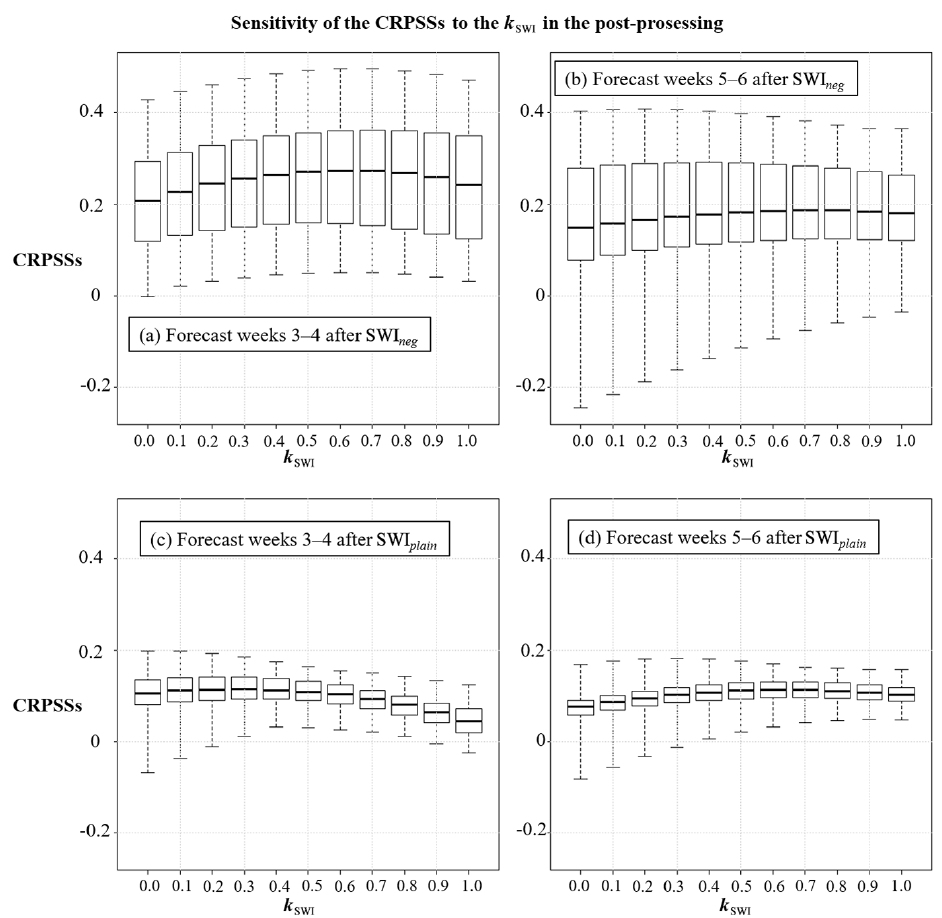
Figure 4. Sensitivity of the expected CRPSSs of the post-processed ECMWF surface temperature reforecasts to the k SWI ranging from 0.0 to 1.0 in forecast weeks 3–4 (a, c) and 5–6 (b, d) in the cases of SWI neg (a, b) and SWI plain (c, d) . The black boxes show the lower and upper quartiles, and the whiskers illustrate the extremes of the November–February mean CRPSSs for all the grid points in northern